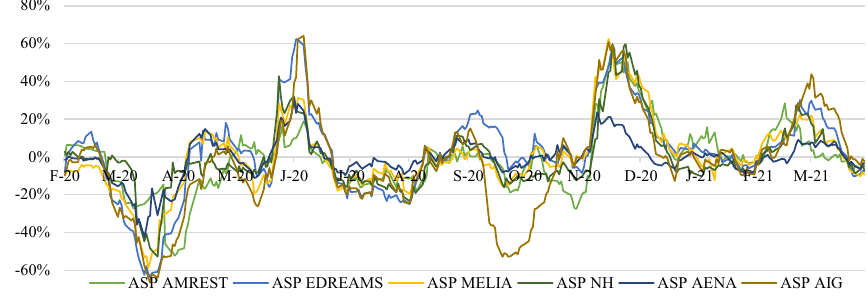
Fig. 4 Abnormal stock prices of companies in the tourism sector (February/2020–April/2021). Source :